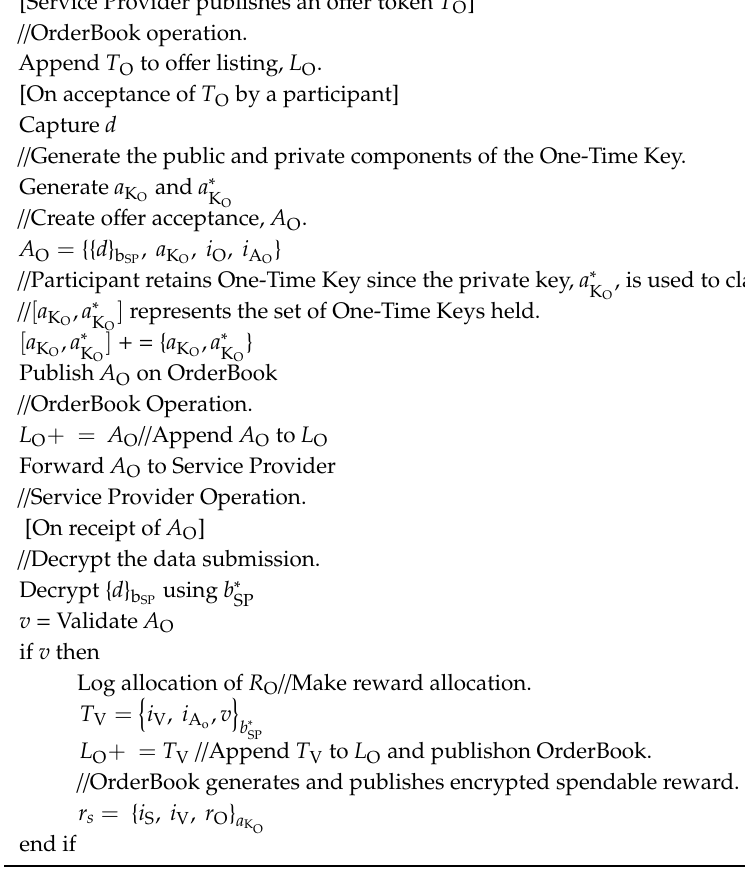
Algorithm 1 : Reward Allocation